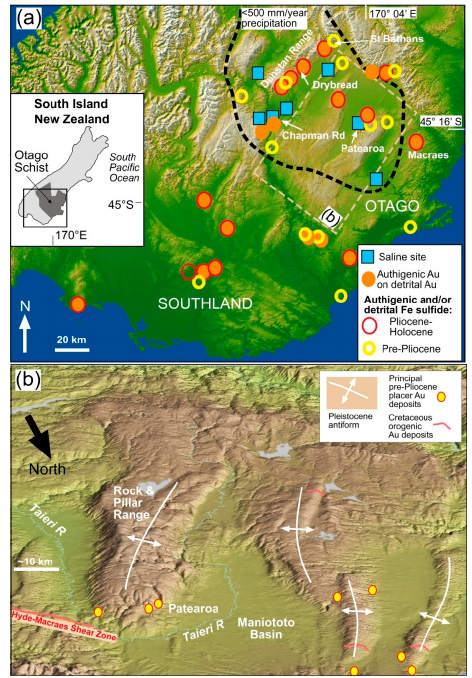
Figure 1. Location images for sites described in this study and their regional mineralogical and climatic contexts. ( a ) Digital elevation model map of southern New Zealand, showing part of the mountain chain to the west that causes a rain shadow, with the approximate boundary of the semiarid portion (black dashed contour). Localities referred to in the Table 1 and some other associated are indicated. Inset shows the extent of the Otago Schist belt, which hosts orogenic gold deposits that form the source for placers described herein; ( b ) Oblique digital elevation model (2 × vertical exaggeration) of the eastern part of the semiarid rain shadow (as indicated with dashed quadrilateral in a ), showing tectonic topography and basement gold deposits.